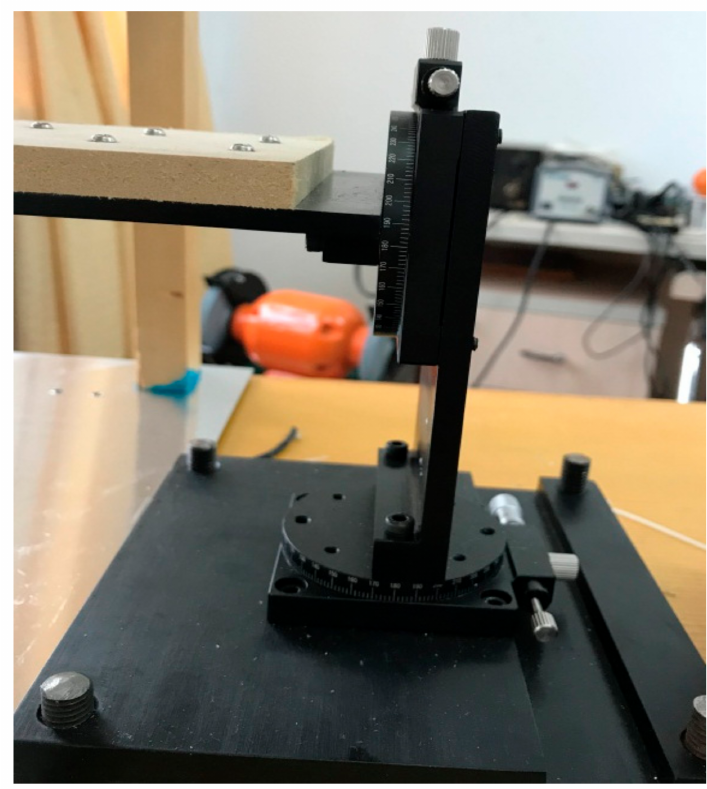
Figure 7. Rotation